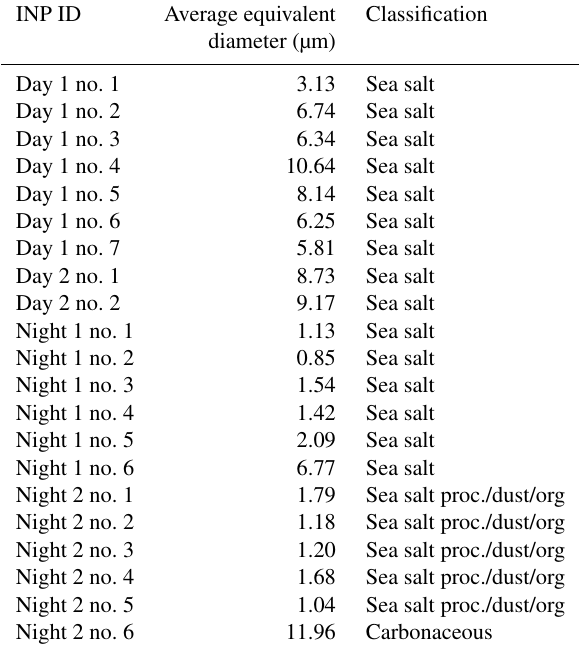
Table 3. Information about identified ice-nucleating particles (INPs) including scanning electron microscopy (SEM)-derived av- eraged equivalent diameter and particle-type